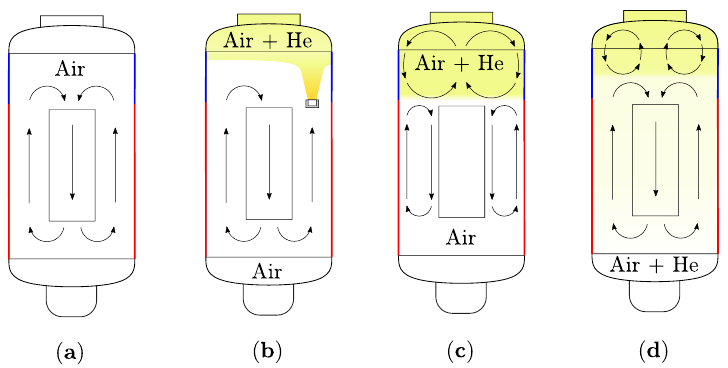
Figure 2. Consecutive phases of the TH22-experiment: ( a ) initial phase, ( b ) injection phase, ( c ) start of erosion phase, and ( d ) final erosion